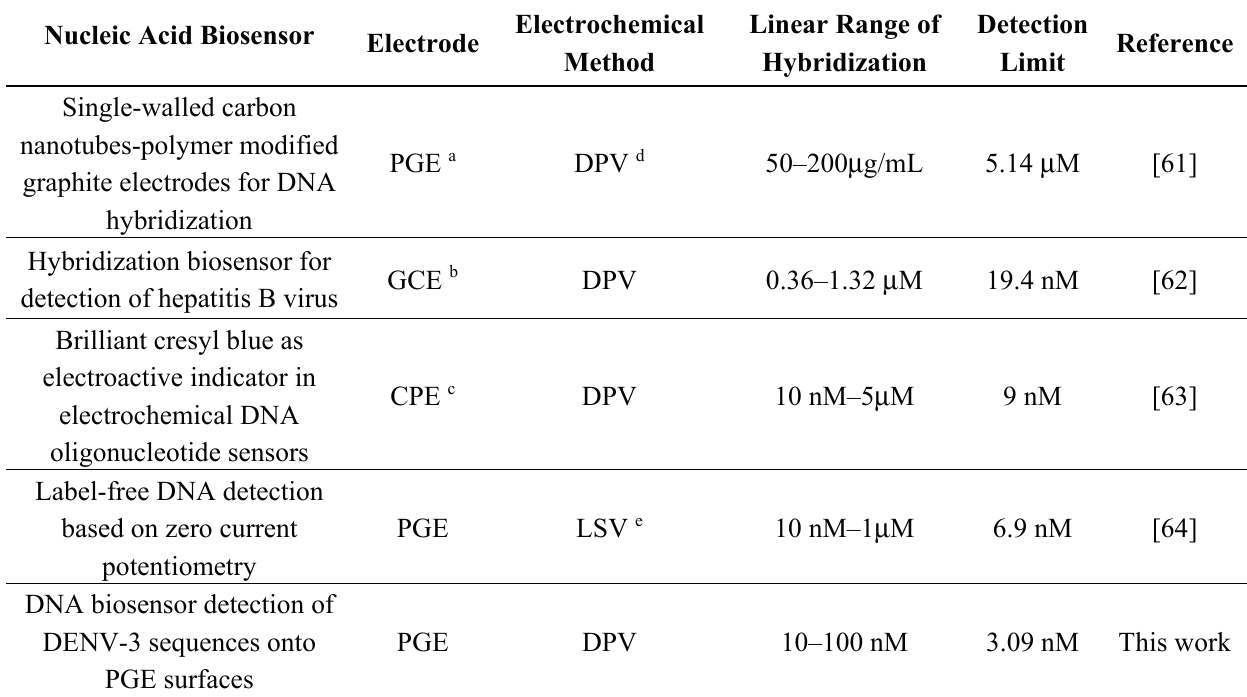
Table 1. Comparison of the analytical performance of different electrochemical DNA biosensors. Nucleic Acid